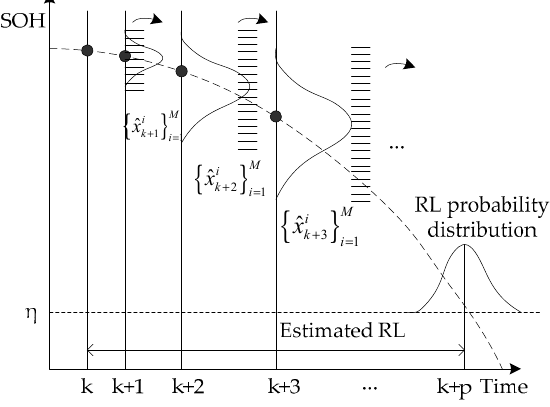
Figure 2. The multistep iterative prediction and Monte Carlo sampling based on the Bayesian